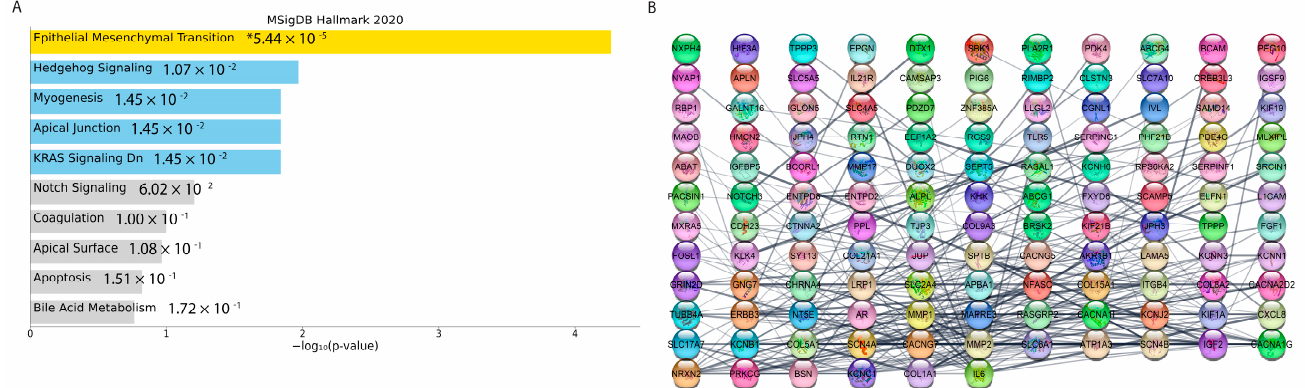
Figure 16. Protein − protein interaction analysis and model . ( A ) Bar plot for pathway enrichment of genes in the blue module. ( B ) Protein − protein interactions of top genes in the opposite module in a grid layout sorted by degree. * p <